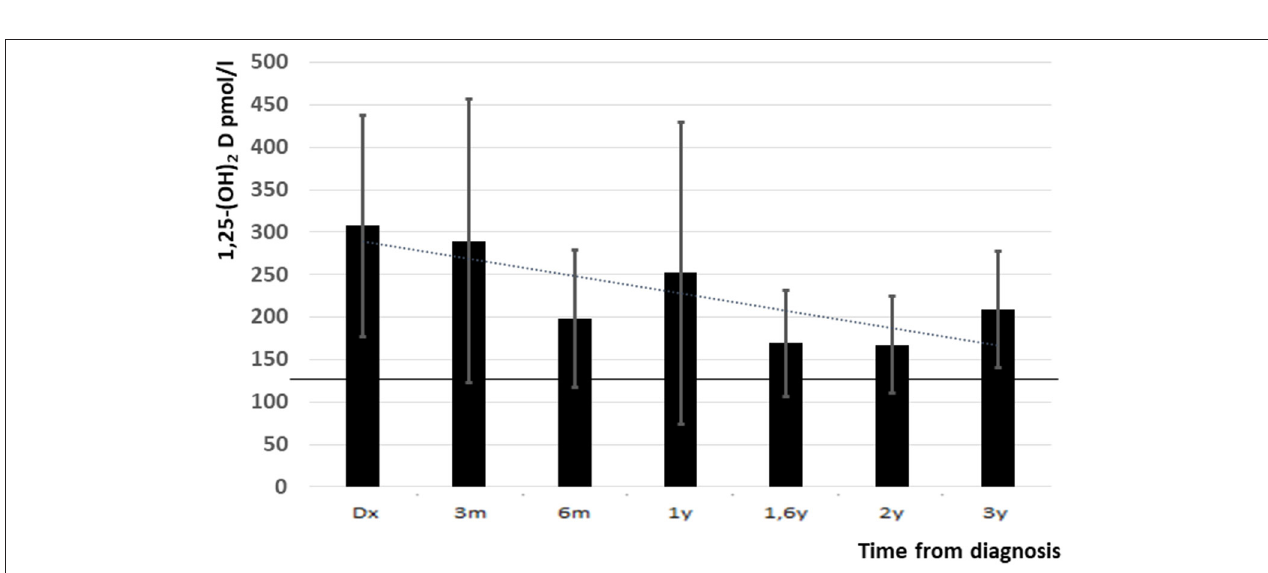
FIGURE 2 | PTH levels from diagnosis and up to 3 years follow up (low normal limit is indicated with black line). Y, years, m, months.